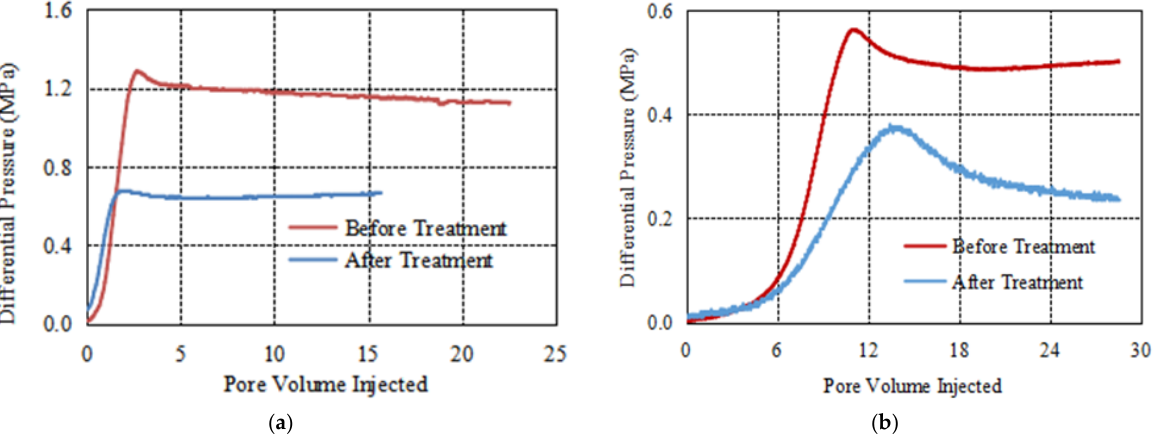
Figure 19. ( a ) Pressure drop versus pore volumes injection for 2 wt% KCl brine before and after treatment of sandstone core plug, unfractured core. ( b ) Pressure drop versus pore volumes injection for 2 wt% KCl brine before and after treatment of sandstone core plug, fractured core [20]. (6)